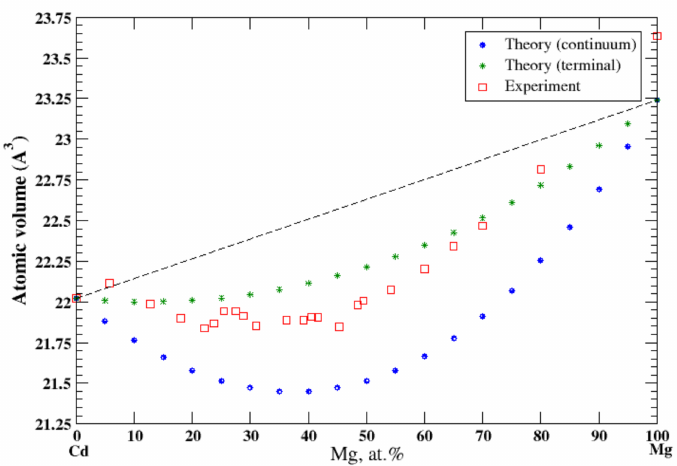
Figure 17. Atomic volume vs. concentration for Cd-Mg alloy system. The experimental data are from Ref. [16] (p. 49 and p.